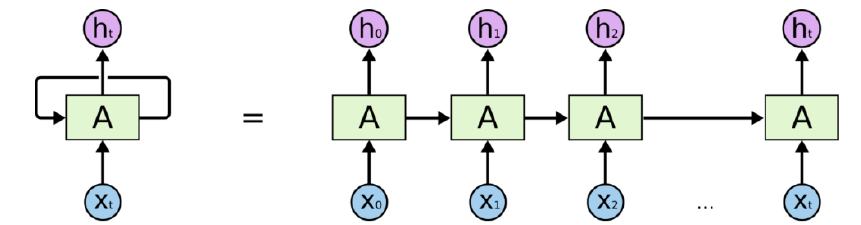
Figure 1. The typical RNN network unit.